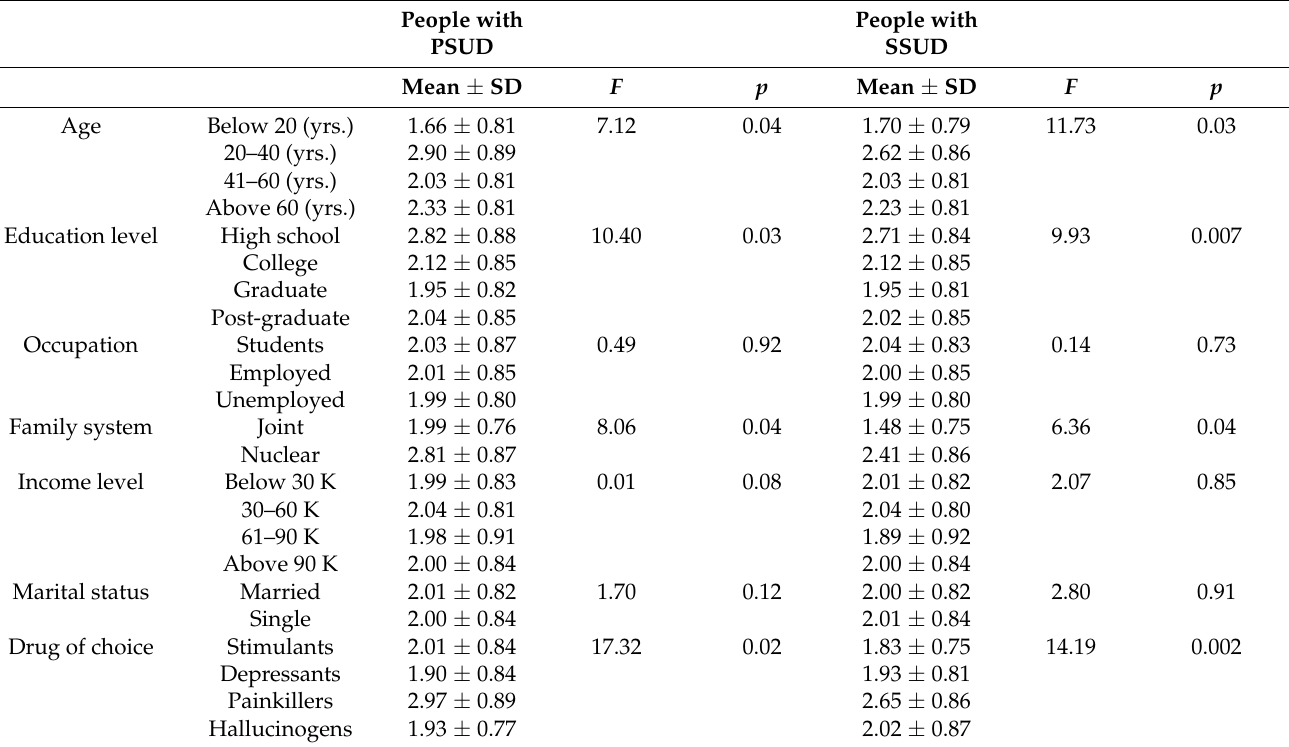
People with SSUD